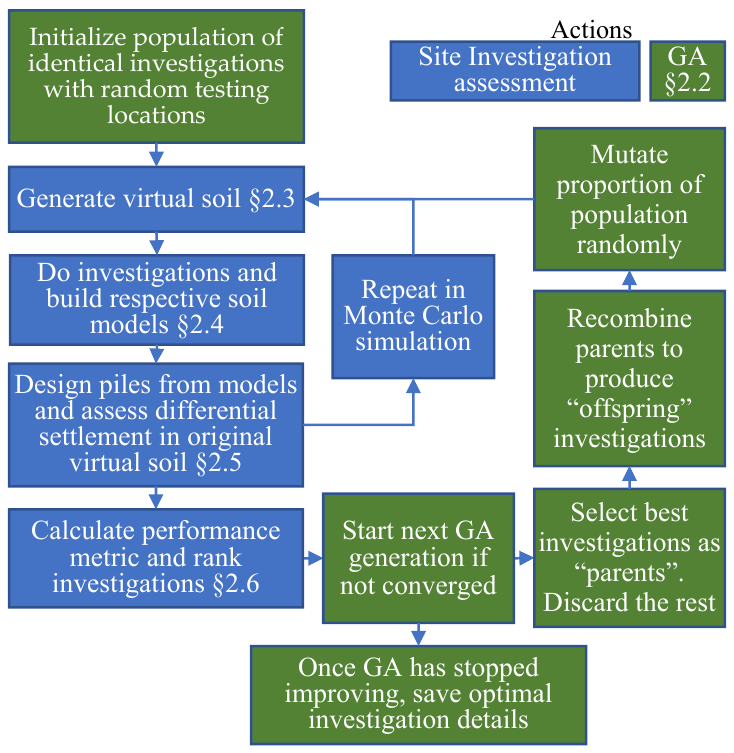
Figure 1. Flow chart for the process of optimizing an investigation's borehole locations. GA, genetic algorithm.